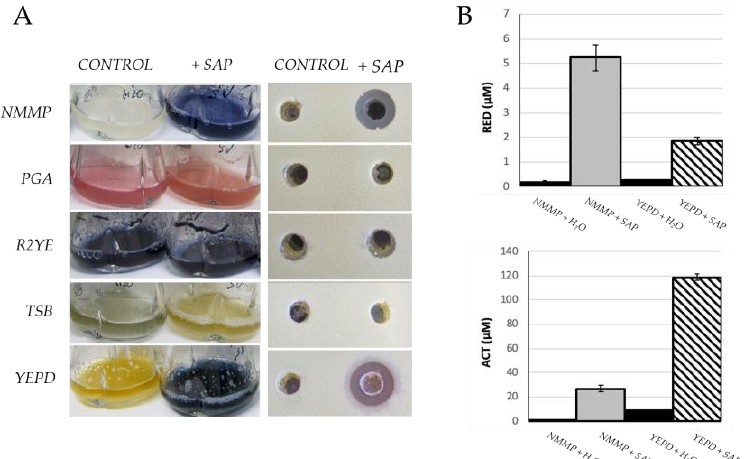
Figure 1. ( A ) Effect of grapevine sap over the production of antibiotics by S. coelicolor grown in the indicated medium (NMMP, PGA, R2YE, TSB, and YEPD) diluted by one-half with water (CONTROL) or with sap (+SAP). Left panel: qualitative observation of colored antibiotic production of the different cultures (blue: ACT; red: RED); right panel: antibiotic activity against M. luteus , 100 µ L of the corresponding extract (CONTROL or +SAP) were deposited in each well. ( B ) Quantification of RED and ACT produced by S. coelicolor grown in NMMP or YEPD media diluted by one-half with water or grapevine xylem sap. All the experiments were performed four times with three biological replicates each.